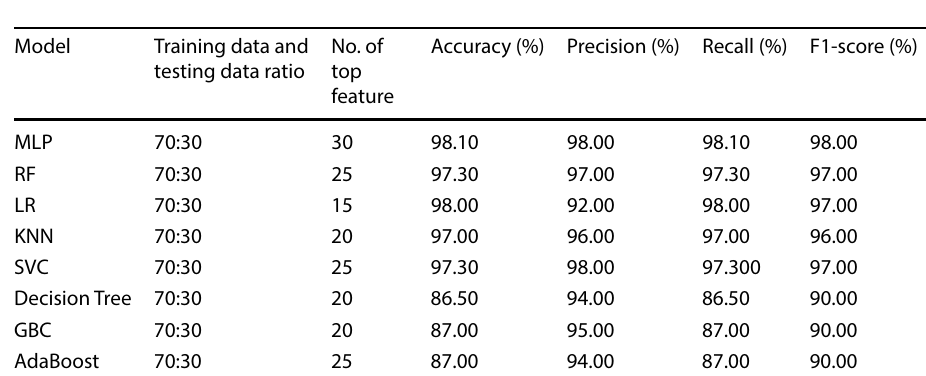
Table 7 Highest performance comparison of different classification